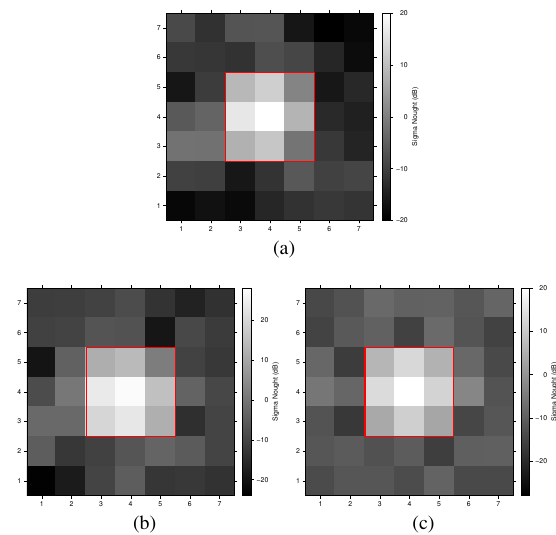
Figure 4. (a)/(b)/(c) Detailed energy distribution of CR1/CR2/CR3.